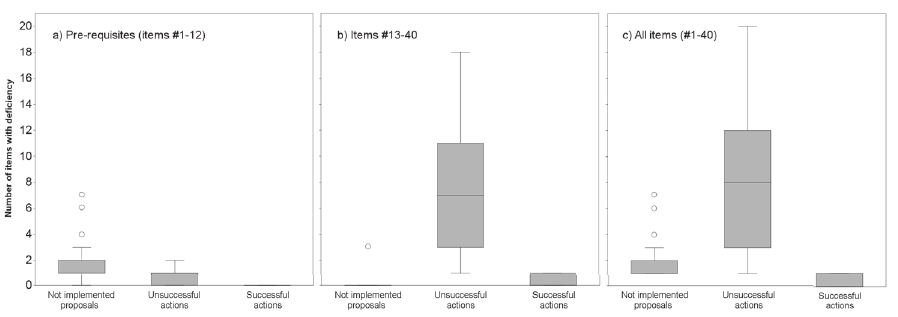
Figure 3. Number of items with deficiency in each action type. The block of prerequisites ( a ) was analysed separately from the rest of checklist items ( b ). In c the number of deficiencies is shown for all checklist